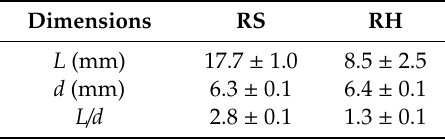
Table 5. Averaged dimensions of RS and rice husk (RH)